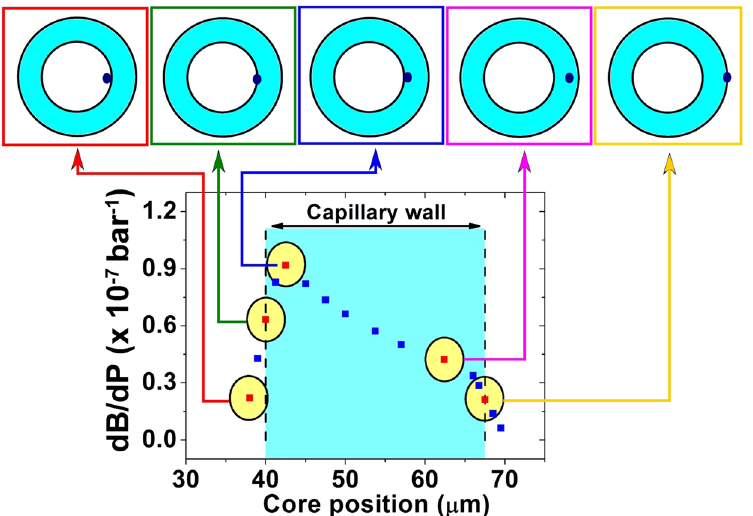
Figure 4. Modal birefringence simulation results. Modal birefringence derivative as a function of the core position in the capillary fibre wall. Blue region represents the capillary wall region, whereas yellow ellipses represent the core area. Insets illustrate the core location within the capillary